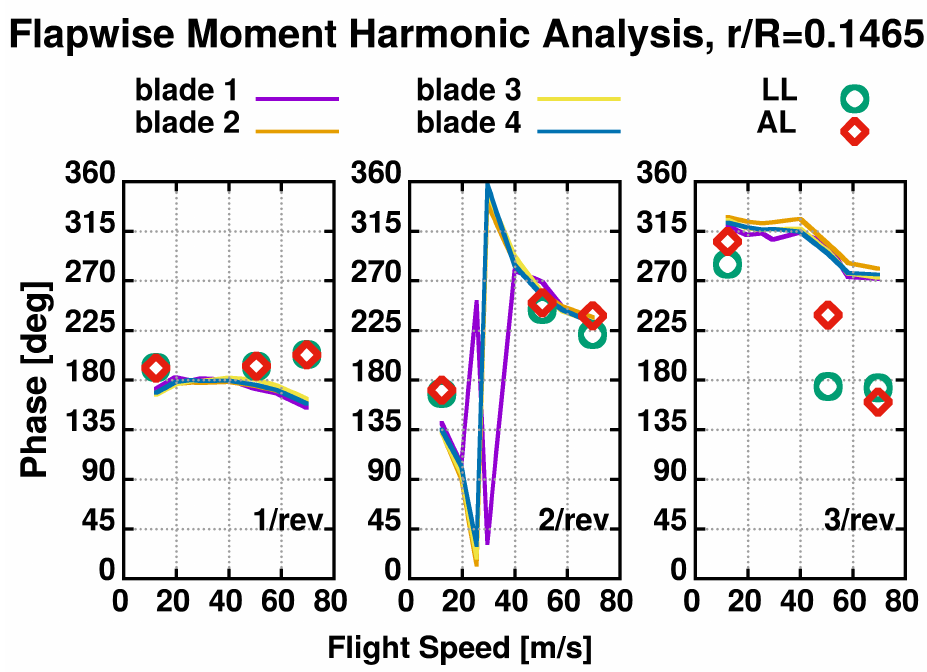
Figure 45. Harmonic analysis of Flapwise bending moment. Phase of frequencies with the highest energy